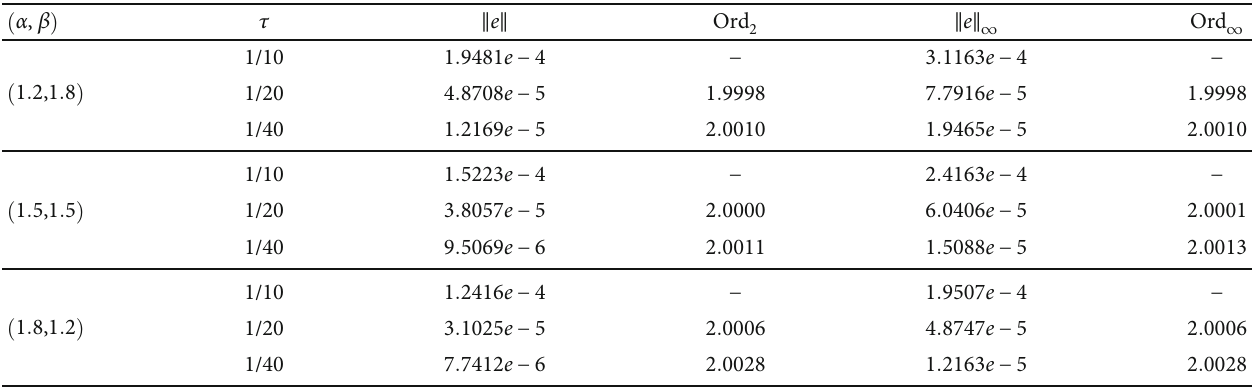
Table 2: l 2 - and l ∞ -errors and their convergence orders of (28) – (30) for 1 < α < 2 in the temporal direction for (72) with fi xed spatial step h = 1/2000 for Example 1.